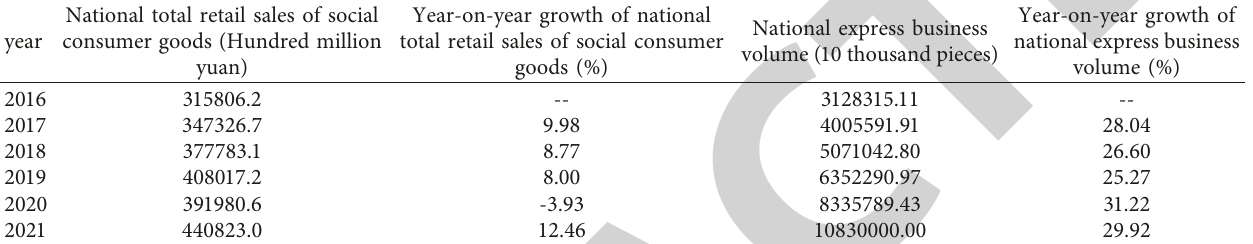
Figure 1: The logical structure of new retail Omni channel. Table 2: Comparison of national total retail sales of social consumer goods and national express business volume.